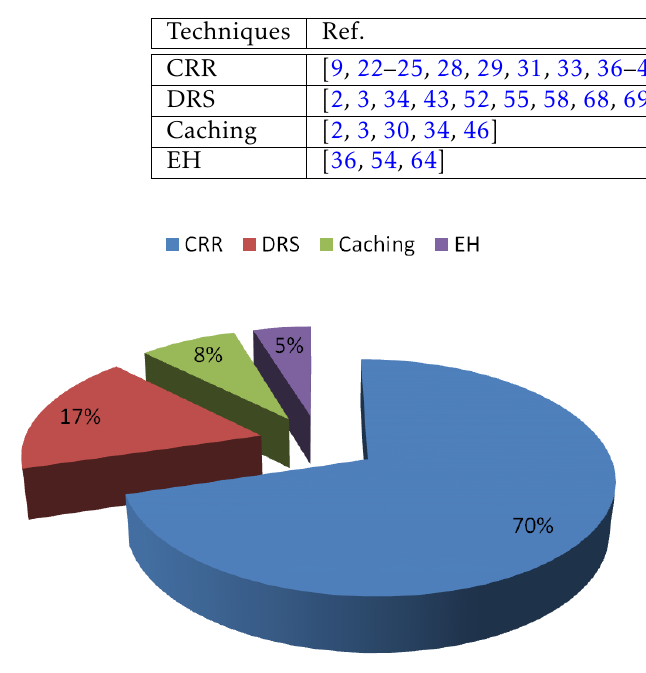
Figure 4. Key techinques of D2D MHMP